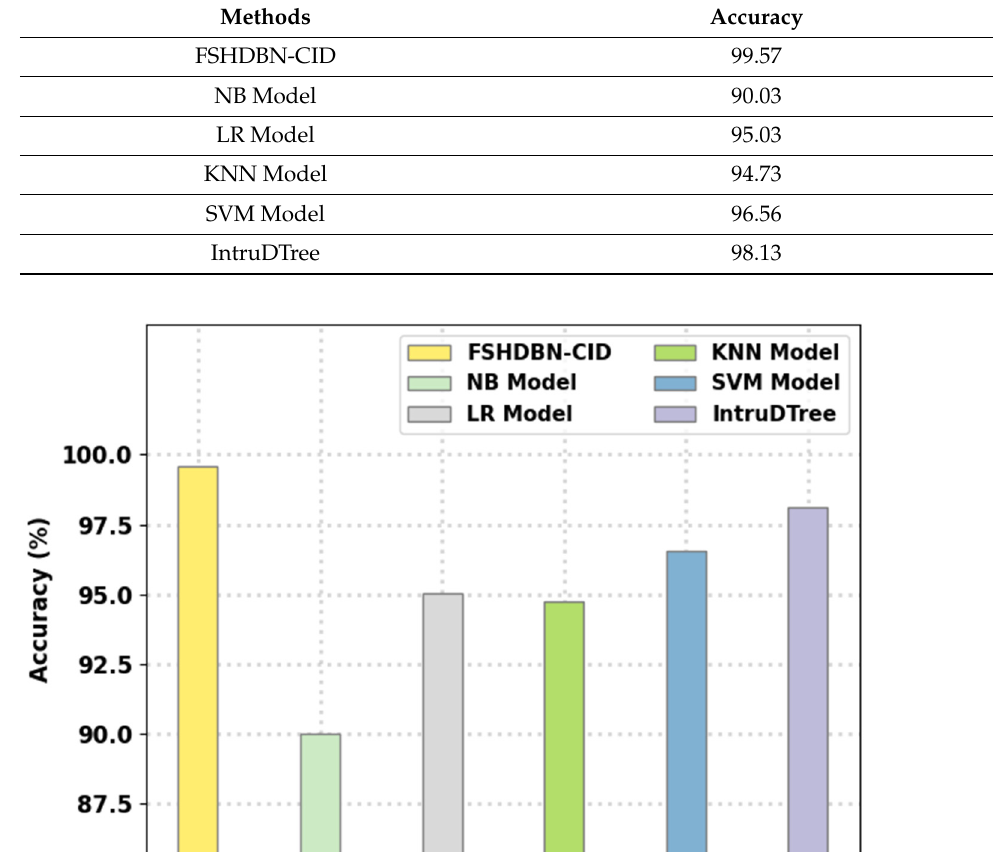
Table 4. Comparative analysis of FSHDBN-CID approach with existing methodologies.